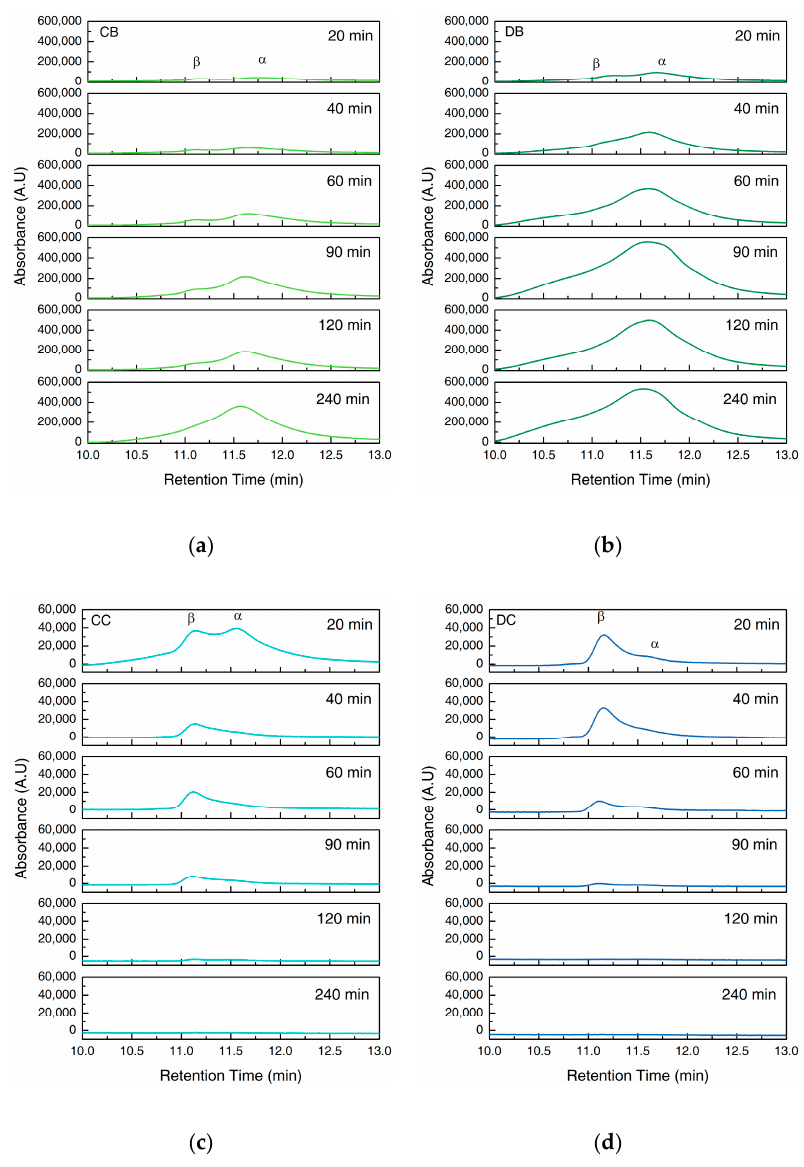
Figure 5. Chromatograms of size-exclusion chromatography (SEC) of supernatants collected at a wavelength of 210 nm. ( a ) C-coll hydrogel in Tris bu ff er, pH 7.4 (CB); ( b ) D-coll hydrogel in Tris bu ff er, pH 7.4 (DB); ( c ) C-coll hydrogel in collagenase solution in Tris bu ff er, pH 7.4 (CC) and ( d ) D-coll hydrogel in collagenase solution in Tris bu ff er, pH 7.4 (DC). Peaks are labelled as: β = collagen β chains; α = collagen α chains.